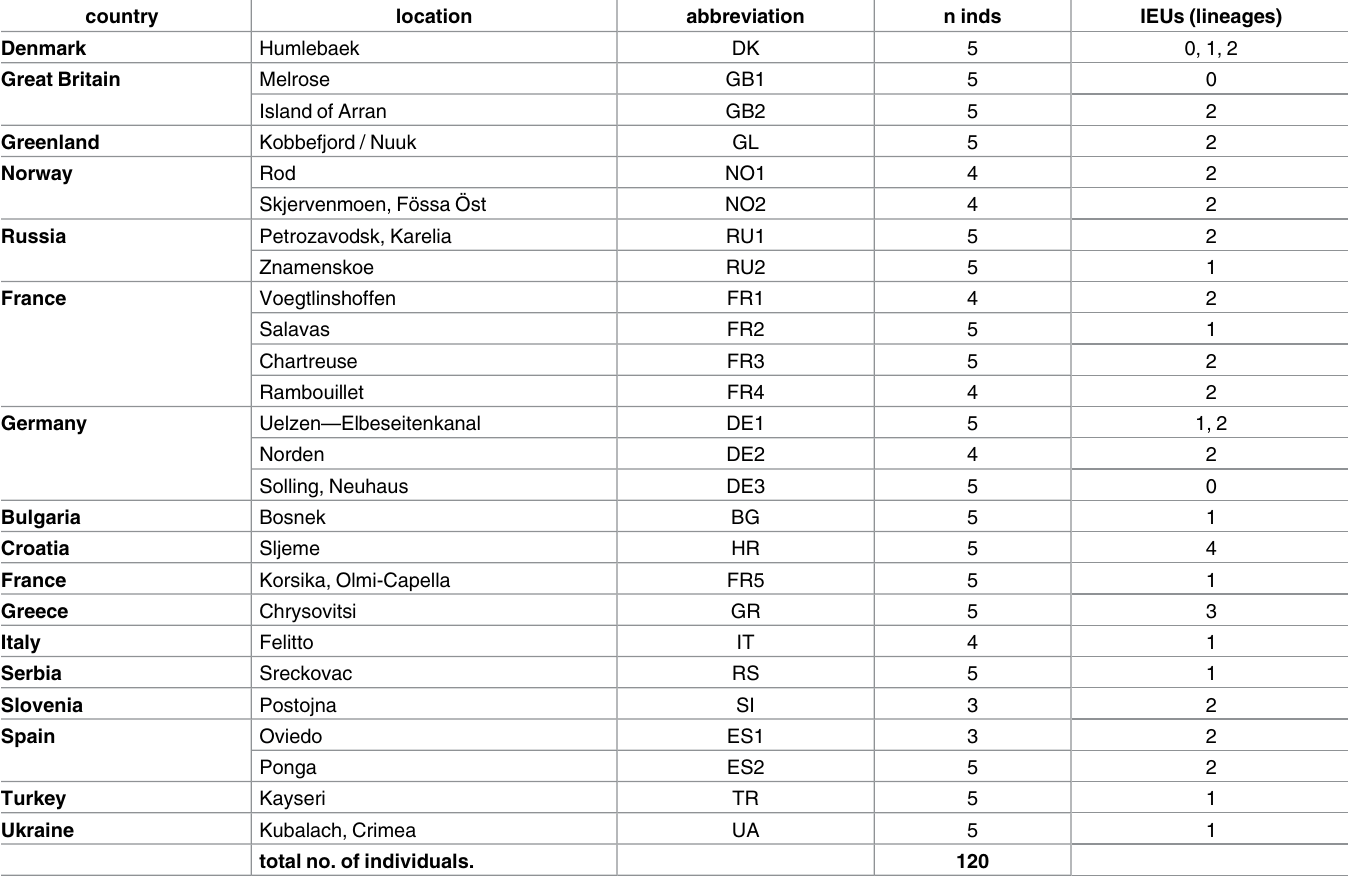
Table 1. Countries and sampling locations of Parisotoma notabilis